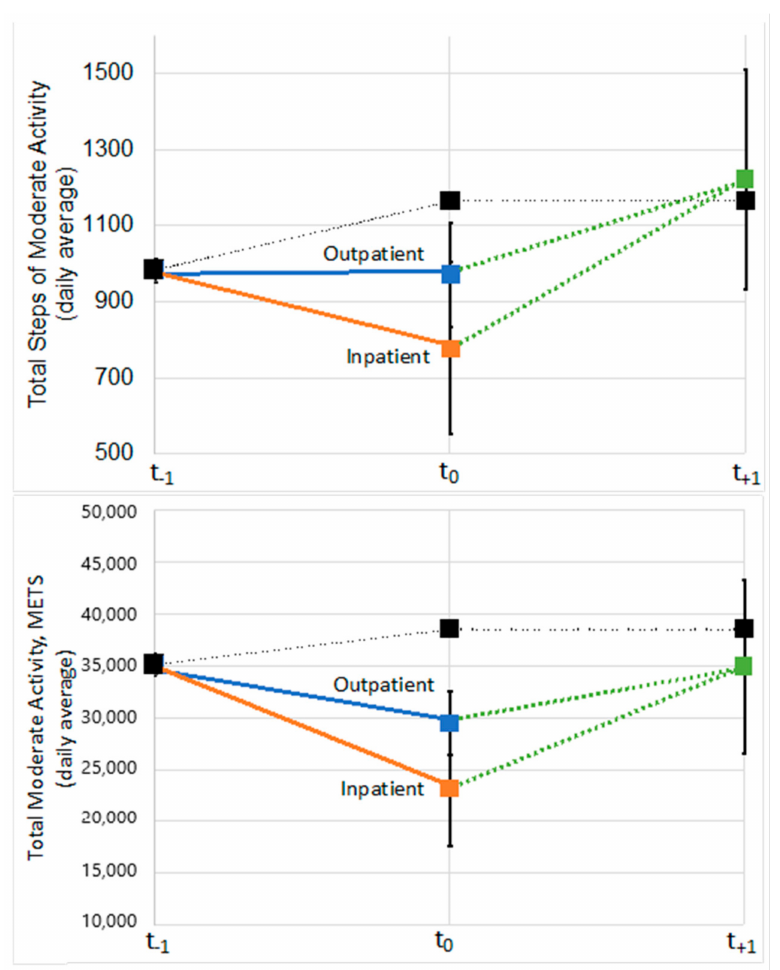
Figure 4. Change in total steps during moderate-intensity activities and total metabolic cost (METs) during moderate-intensity activities from the period prior, during, and immediately after a pneumo- nia episode. Group means were similar at baseline and those with outpatient (blue) and inpatient (orange) pneumonia events, decreased, then returned to baseline in the subsequent period (green). Those without any pneumonia events are shown in black. Due to sample sizes, inpatient and outpatient pneumonia groups were grouped together in the